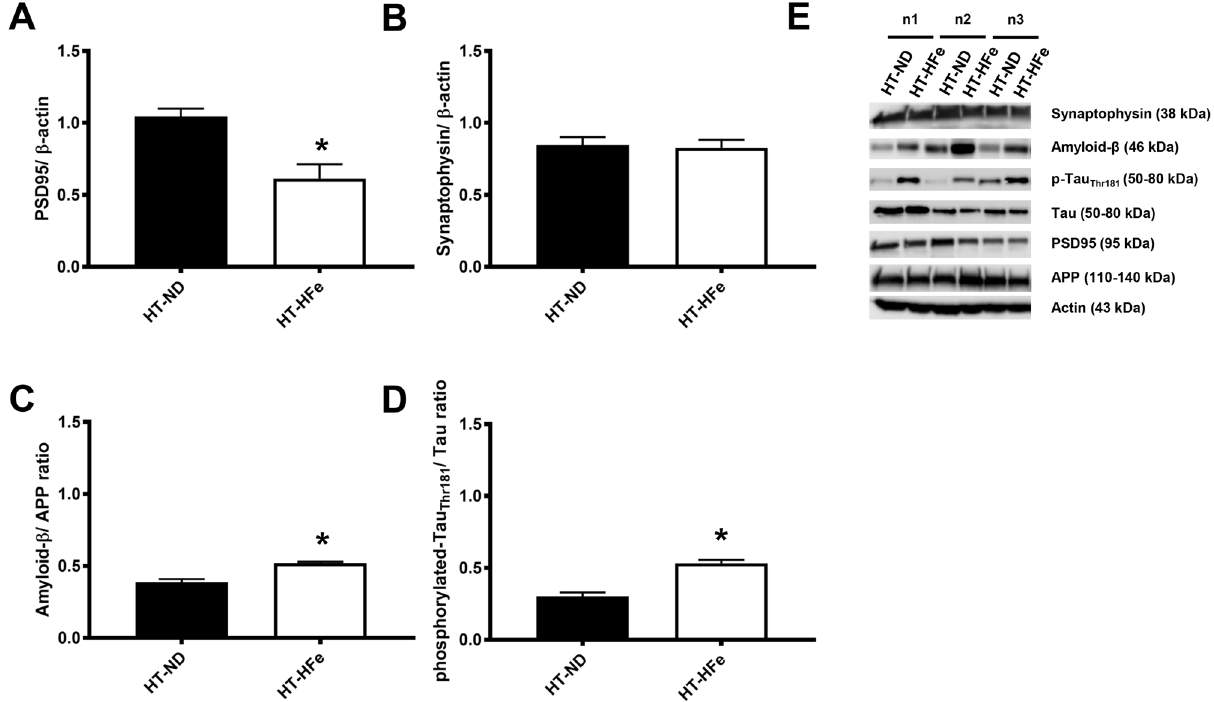
Figure 3. Brain synaptic proteins including PSD95 ( A ) and synaptophysin ( B ) and Alzheimer’s related proteins including the ratios of Amyloid-β/APP ( C ) and phosphorylated-Tau Thr181 /Tau ( D ) of β-thalassemic mice fed with either normal diet or high-iron diet. Three replicates of cropped representative bands for brain FGF21 signaling proteins are shown ( E ). In addition, full-length blots are presented in Supplementary Fig. 2. The samples derive from the same experiment and that gels/blots were processed in parallel. Actin was used as a loading control and the density of detected protein was divided by the density of actin from the sample. APP amyloid precursor protein, HFe high-iron diet fed mice, HT heterozygous-β knockout, ND normal diet fed mice, PSD95 post-synaptic density 95. *p < 0.05 vs. HT-mice fed with normal